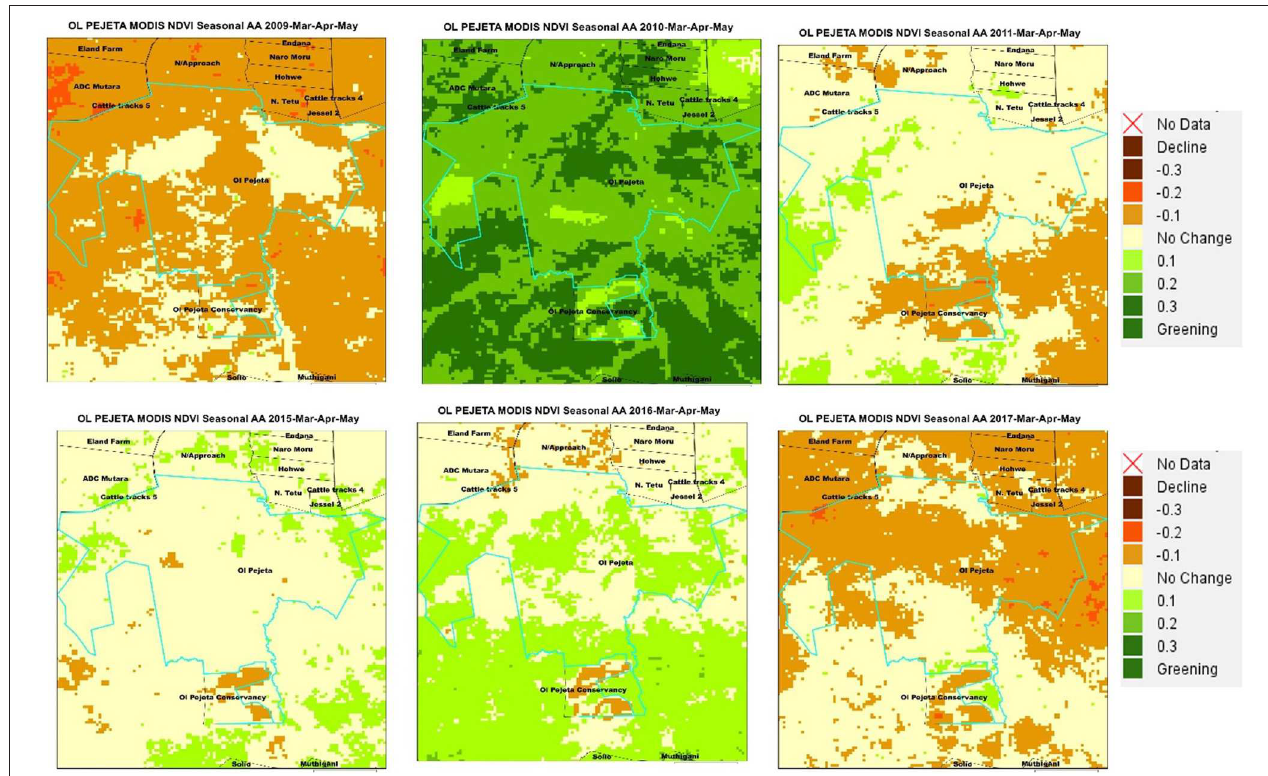
FIGURE 6 | Drought progression between 2009 and 2011, and 2017 to 2017 long rains season in ol-pejeta conservancy using absolute anomalies.